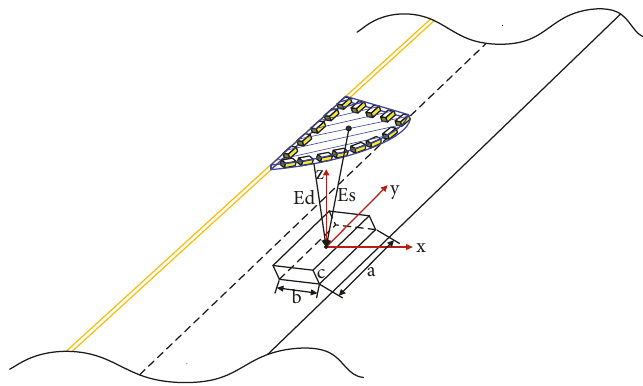
Figure 5: Static field strength (Es) and dynamic field strength (Ed) of centralized pressure source.